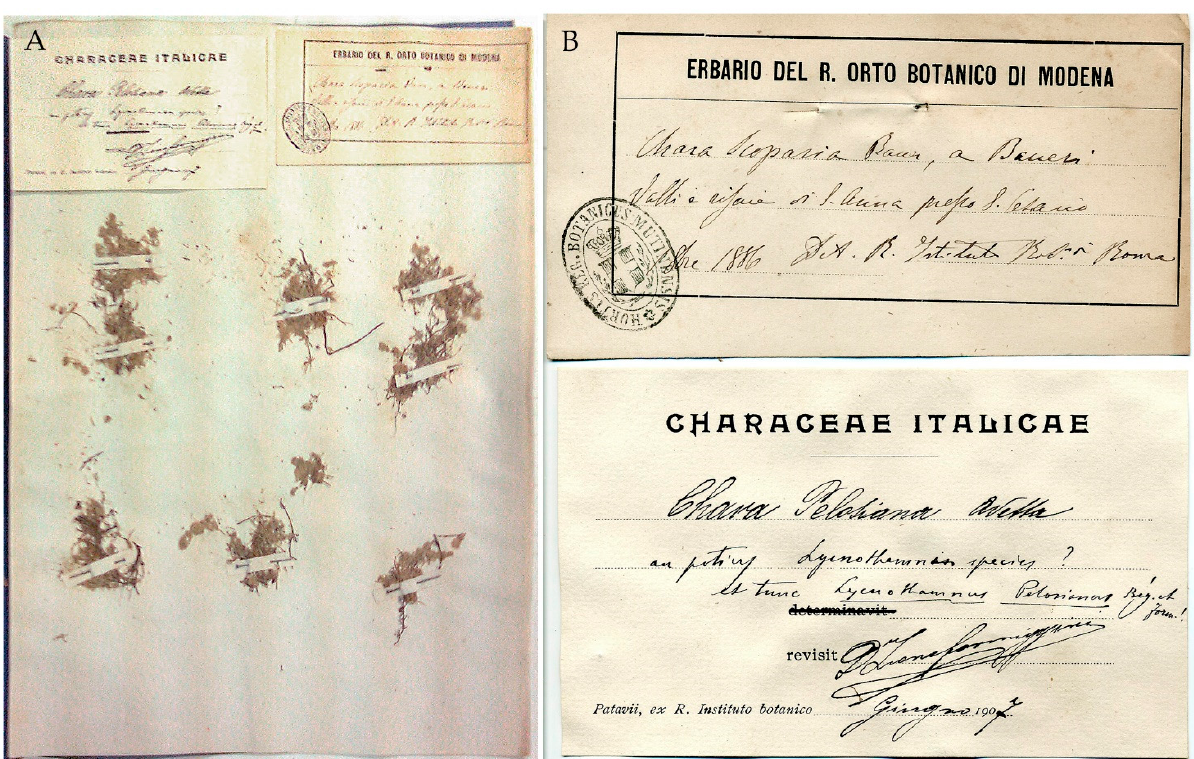
Figure 2. ( A ) MOD specimens of Chara pelosiana from the first duplicate of Ferrari’s original collection. ( B ) MOD preprint label with unknown handwriting (above) and Formiggini and Béguinot’s preprint revision label (below).